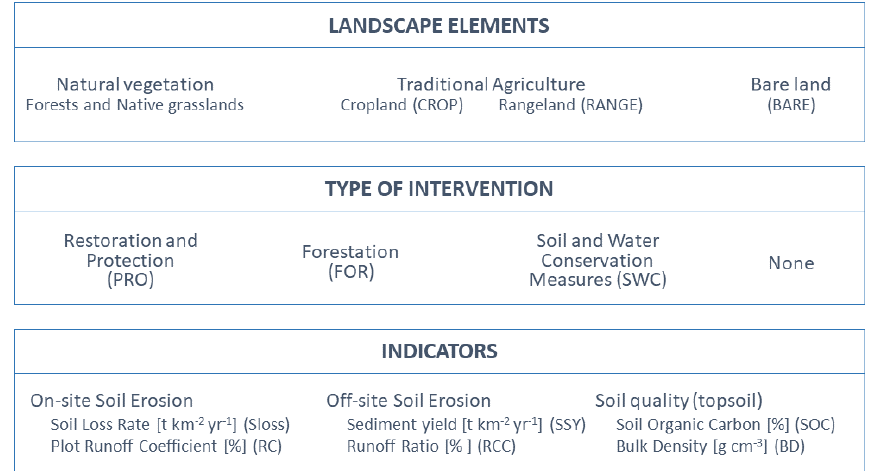
Figure 2. Schematic overview of study design.